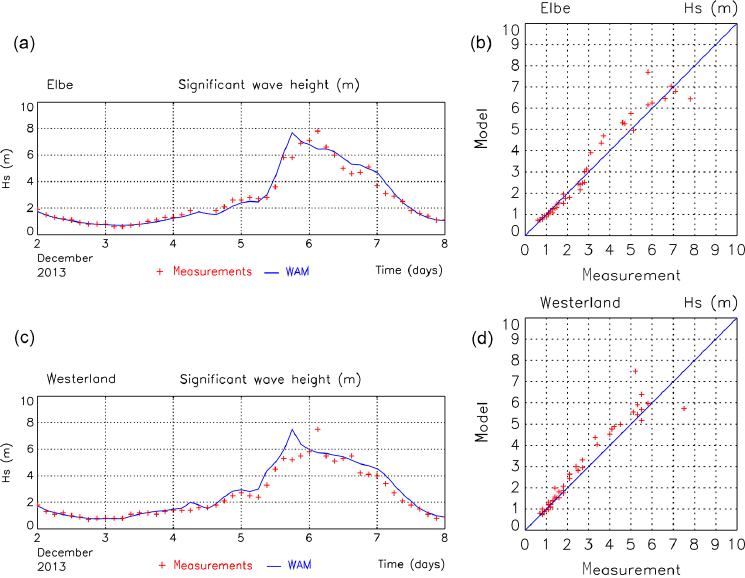
Figure 4. Time series (left) and scatter plots (right) of observed (red) and simulated (blue) significant wave height at the Elbe (top) and Westerland (bottom) buoy stations. See Fig. 1 for locations.